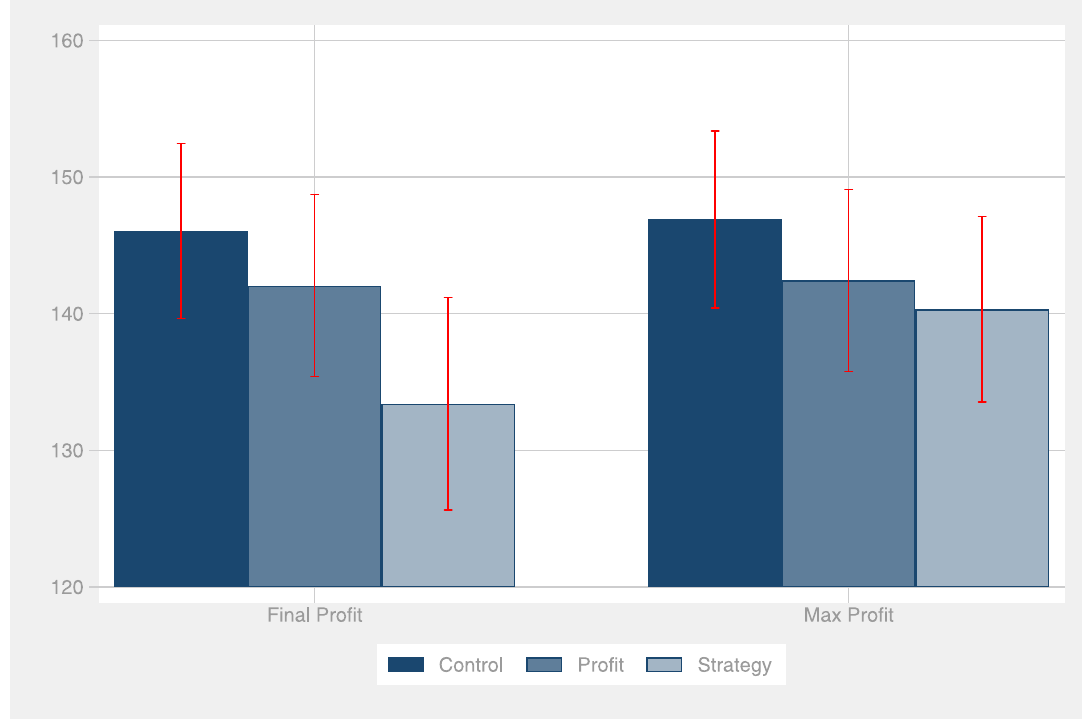
Fig 1. Means of the final and the maximum profits. The figure reports the means of the final and the maximum profits for each experimental group. Error bars indicate standard errors of the